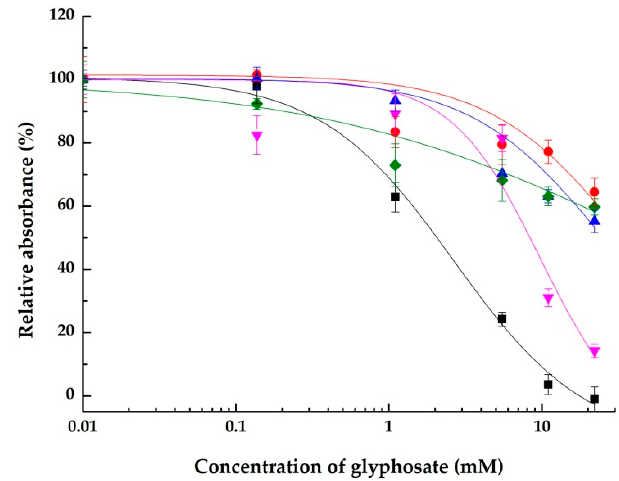
Figure 4. Concentration-dependent inhibitory effects of glyphosate on the integrins α V β 3 using RGD (black), α 5 β 1 using RGD (pink), α V β 3 using vitronectin (blue), α llb β 3 using fibrinogen (green) and α V β 3 using S-protein (the SARS-CoV-2 spike protein receptor binding domain) (red). Data are shown as means ± SD.